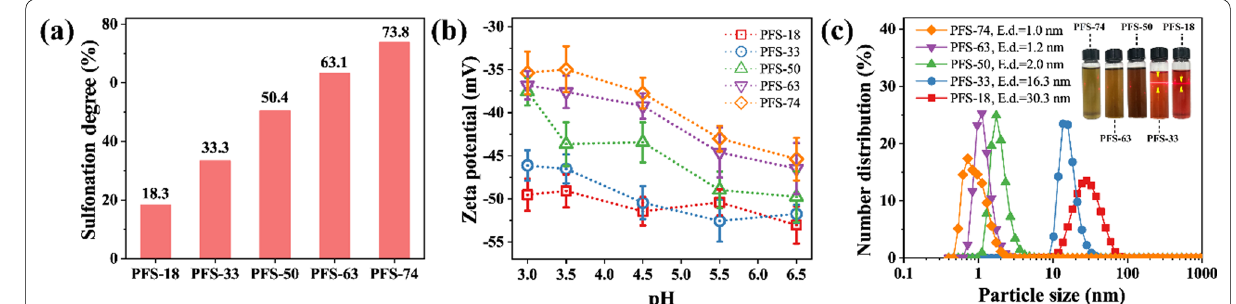
Fig. 3 a DS of PFS; b effect of DS on zeta potential of PFS; c distribution of particle size of PFS in aqueous